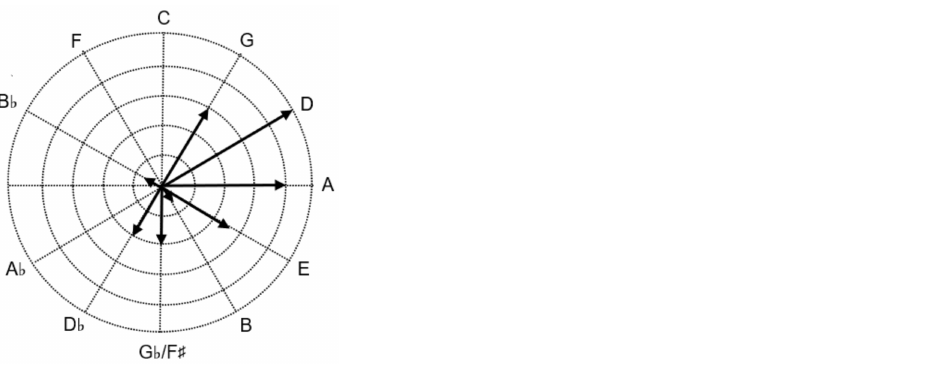
Figure 2. The music signature obtained for the fragment of the musical piece presented in Figure 1.